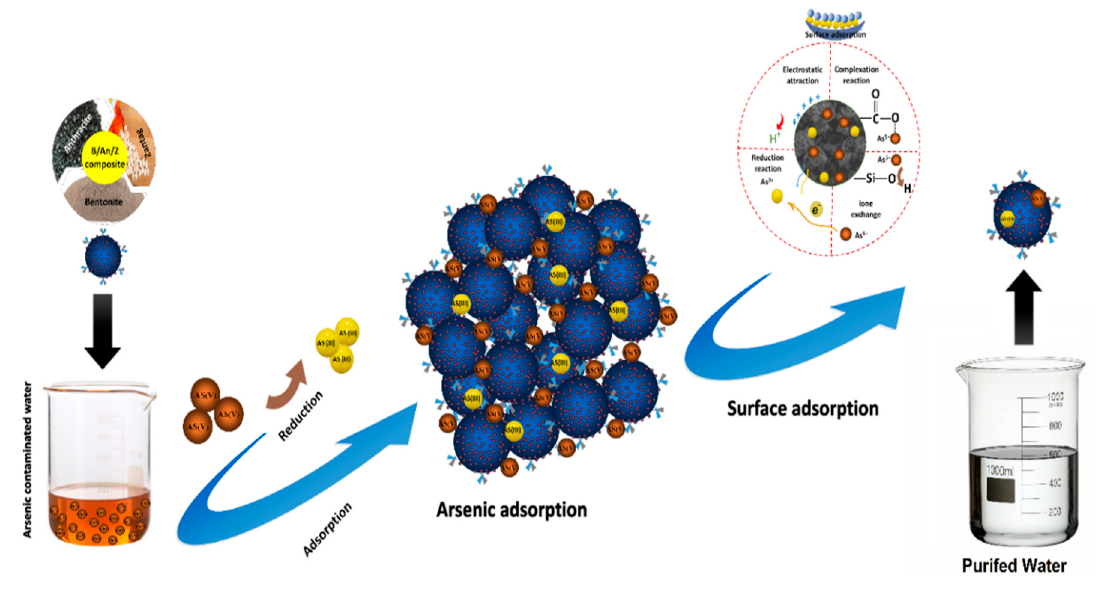
Figure 9. Mechanism of the As(V) adsorption by the BT-An@Zetag adsorbent composite.